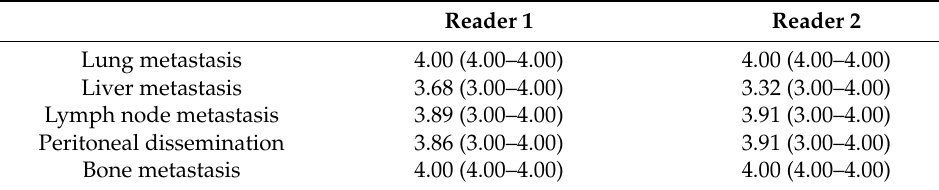
Table 6. Diagnostic reliability of tin-filtered 100 kV image quality.